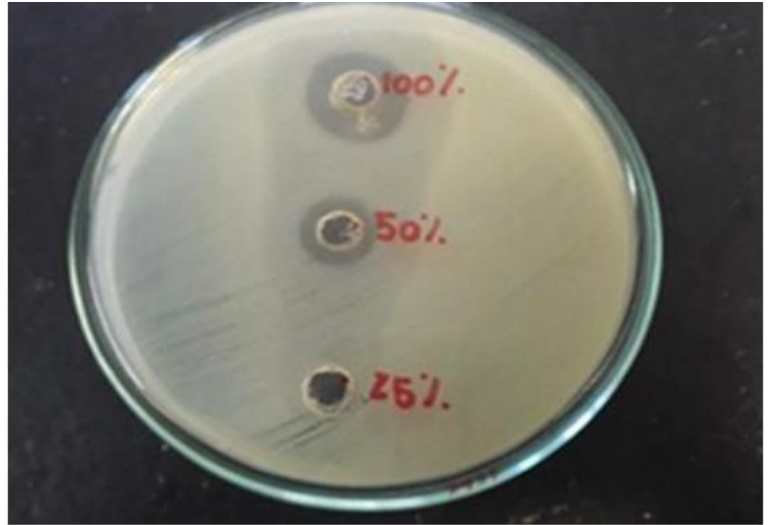
Figure 1. Antimicrobial test with different concentrations (25%, 50%, and 100%) of S. aff. postica honey against E. coli.